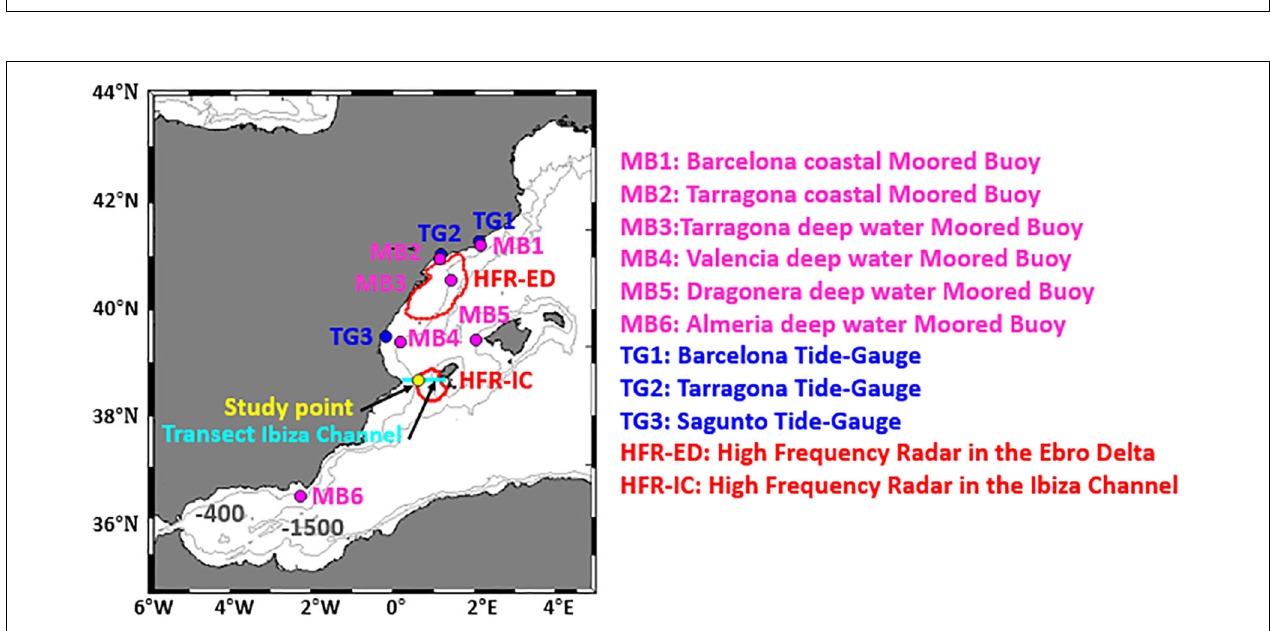
FIGURE 2 | Location of the in situ observational stations (including mooring buoys, tide-gauges, and coastal meteorological stations) used in the model intercomparison exercise. Coverage of the two HF radars used in the study (red polygons) is also depicted.